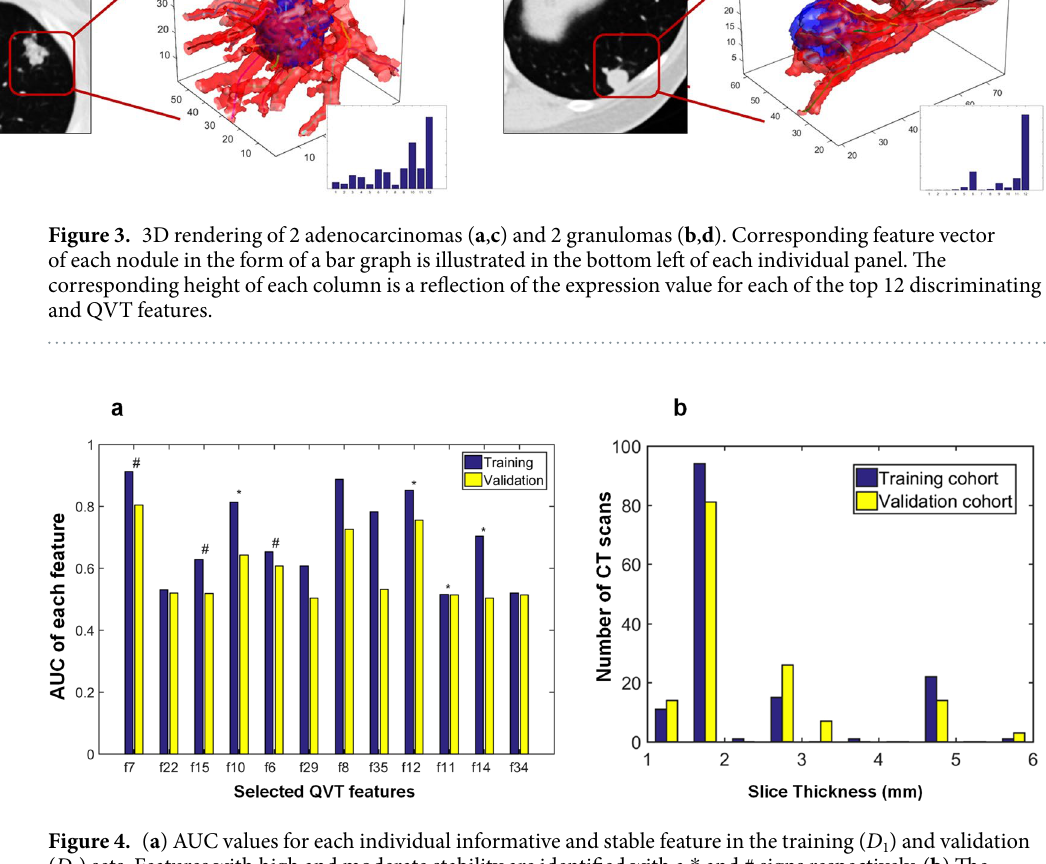
Figure 4. ( a ) AUC values for each individual informative and stable feature in the training ( D 1 ) and validation ( D 2 ) sets. Features with high and moderate stability are identified with a * and # signs respectively. ( b ) The distribution of slice thicknesses on both D 1 (blue) and D 2 (yellow) respectively. X and Y axes respectively represent the slice thickness in millimeters and the number of CT scans with corresponding slice thickness in both D 1 and D 2 ,